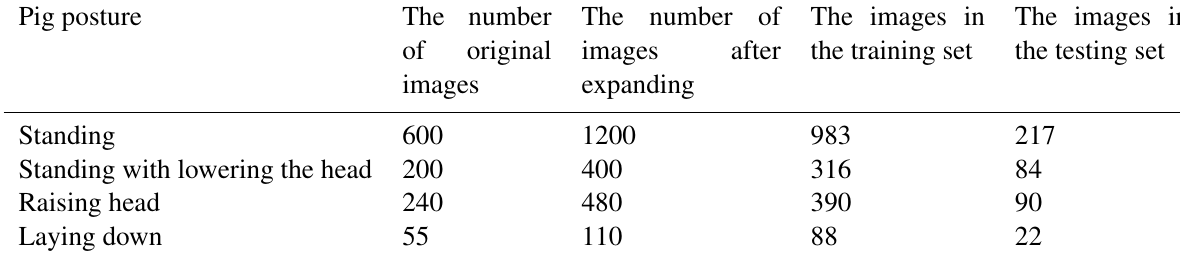
Table 2 Distribution of training and testing images for dataset 1.